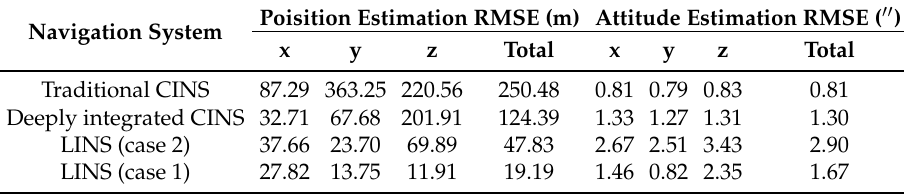
Table 4. State estimation accuracy of different navigation